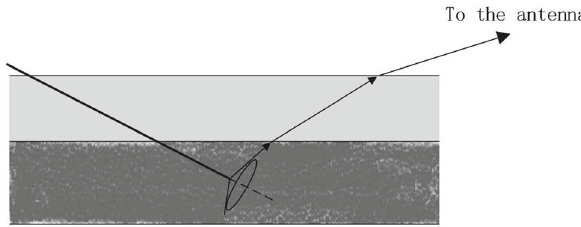
Fig. 6 Direct and reflected radio emissions initiated by the UHE neu- trinos propagate between the lunar soil and lunar orbital radio antenna. The lunar soil is modelled with two layers, the regolith and the sub- regolith